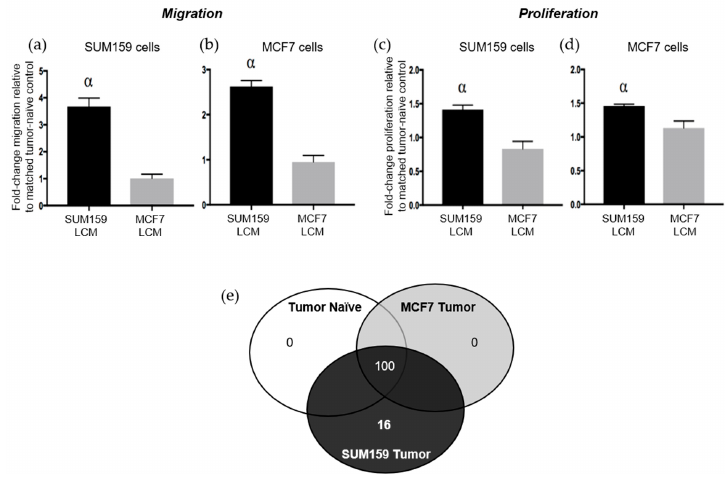
Figure 5. The presence of a triple-negative SUM159 breast tumor modifies the soluble lung microenvironment to enhance breast cancer cell migration and proliferation. Triple-negative SUM159 or luminal A MCF7 human breast cancer cells were injected into the mammary fat pad of female nude mice, and primary breast tumors were allowed to develop up to a mean tumor size of 1500 mm 3 . Animals were euthanized at the endpoint, and lungs were harvested and used for the generation of lung-conditioned media (LCM) as described previously [9]. To assess migration, ( a ) SUM159 or ( b ) MCF7 cells were subjected to transwell migration assays for 18 h as described in the Materials & Methods. To assess proliferation, ( c ) SUM159 or ( d ) MCF7 cells were subjected to BrdU incorporation assays as described in the Materials & Methods. Five high-powered fields of view (HP-FOV) were used to enumerate migrated or proliferating cells using ImageJ software (NIH). Data are presented as the mean ± SEM (LCM from n = 15/mice per group). α = significantly different from LCM from MCF7 tumor-bearing mice ( p < 0.05). ( e ) RayBio ® Mouse Antibody Array AAM-BLM-1 membranes (RayBiotech; n = 3/group) were exposed to dialyzed, biotin-labeled media samples, washed, labeled with HRP-streptavidin and visualized using chemiluminescence and film exposure. Venn diagram showing the number of similar versus unique proteins identified under each LCM condition.